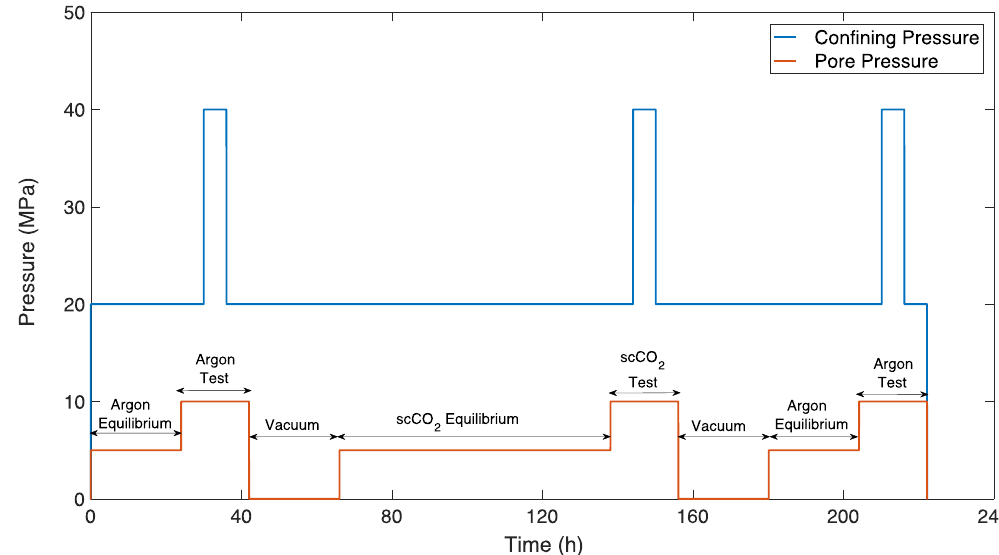
Figure 2. The generic experimental path followed during the experiments. Note that extended cycles of argon/scCO 2 permeabilities were conducted for three samples.